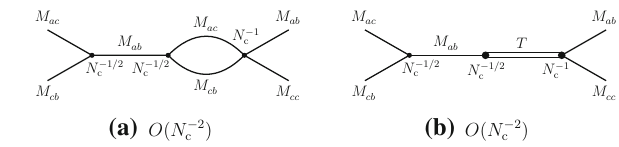
Fig. 14 Mixings,intherecombinationchannel,ofasingle-mesonstate with two-meson ( a ) and tetraquark ( b ) states